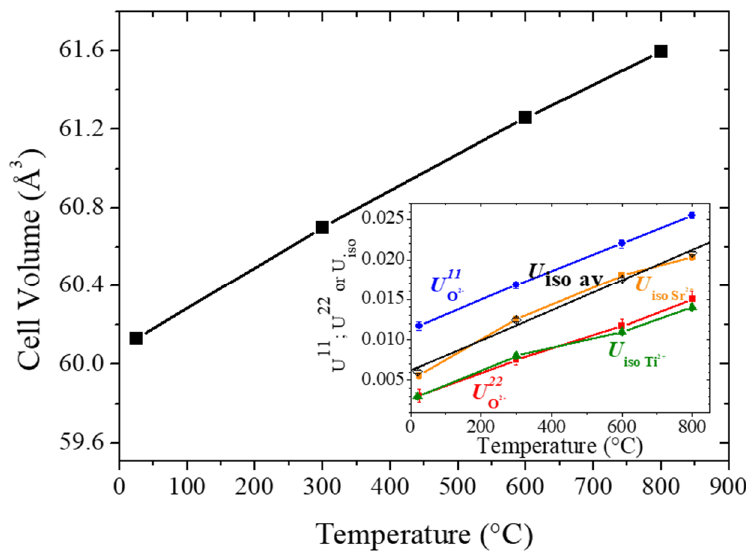
Figure 3. Thermal evolution of the unit-cell volume for Sr 0.9 (Ti 0.9 Nb 0.1 )O 3-δ in the 25–800 °C temperature range. The inset shows the evolution of the atomic displacement parameters (ADPs) for Sr (orange), Ti (green), and O (red and blue) atoms, and the unit-cell averaged U iso (black) and corresponding Debye-fit (black line) with θ D = 452 K. Table 2. Structural parameters after the Rietveld refinement of Sr 0.8 (Ti 0.9 Nb 0.1 )O 3- δ from NPD data at 25 ◦ C in the Pm-3m space group, a = 3.91476 (3) Å, with λ = 1.594 Å. Discrepancy factors: R p = 2.78%,